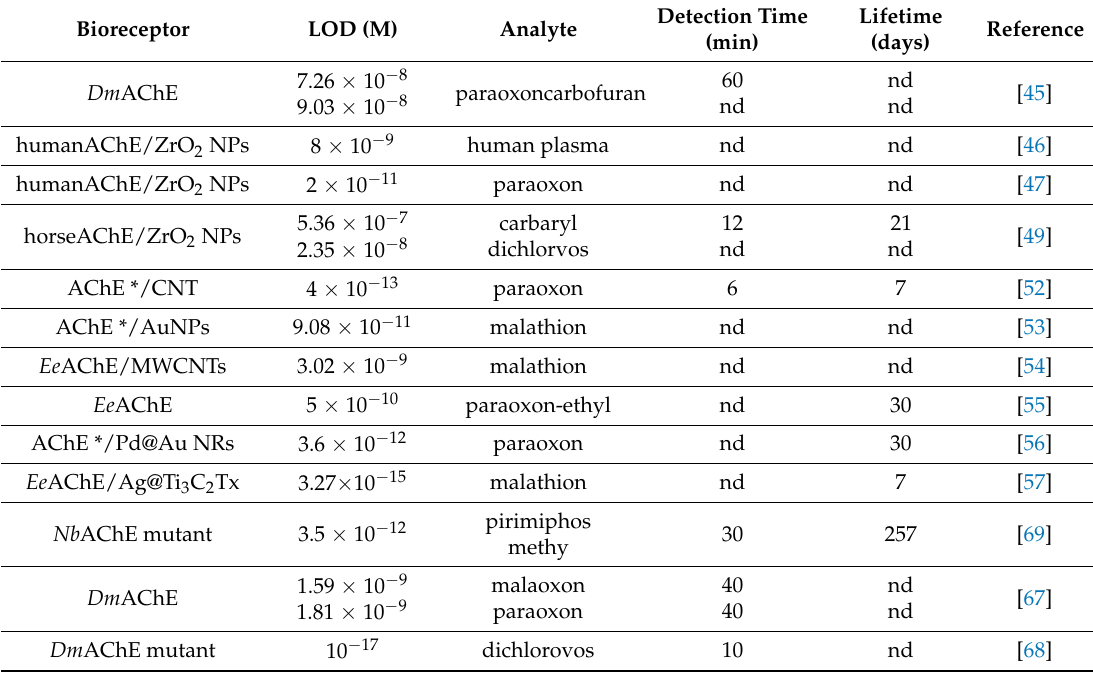
Table 1. Comparison of selected recent ChE-based biosensors with improved limit of detection (LOD).